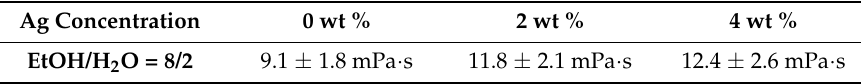
Table 2. The viscosity of zein/Ag nanoparticles electrospun from ethanol aqueous solutions with an ethanol/water ratio of 8/2 ( v/v ) according to Ag concentrations of 0, 2 and 4 wt % (polymer concentration = 10 wt %, TCD = 15 cm, and applied voltage = 15 kV) at 25 ◦ C.